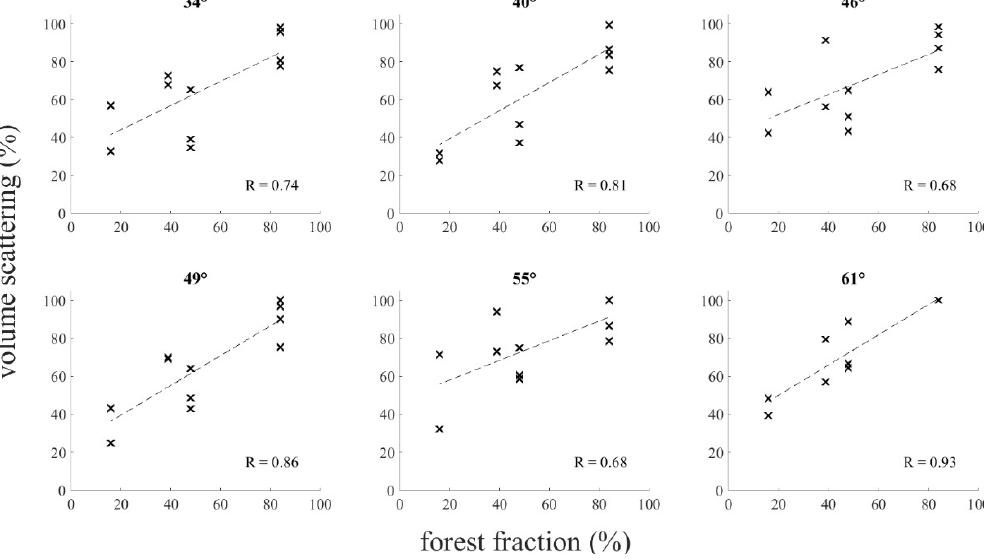
Figure 10. Volume scattering at 9.6 GHz vs. FF for the forested sites at each incidence angle. The line of best fit is for illustrative purposes only. 5. Implications for SAR-Based SWE Retrievals in Forest-Covered Landscapes The scatterometer observations in Sections 4.2 and 4.3 demonstrate the ability to distinguish forested from non-forested landscapes, and either the range profiles or the decomposition results could be used to identify forest. However, the range profile data is not available from a SAR, so only the decomposition results are included in this discussion. For the decomposition approach to be effective, a threshold must be identified, above which, the landscape can be unambiguously identified as forest. Leveraging the strong volume response observed in the forest canopies at both frequencies in Section 4.3, a threshold of V FD ≥50% for forested landscape and V FD <50% for non- forested landscape was applied. This simple threshold yields good agreement between the